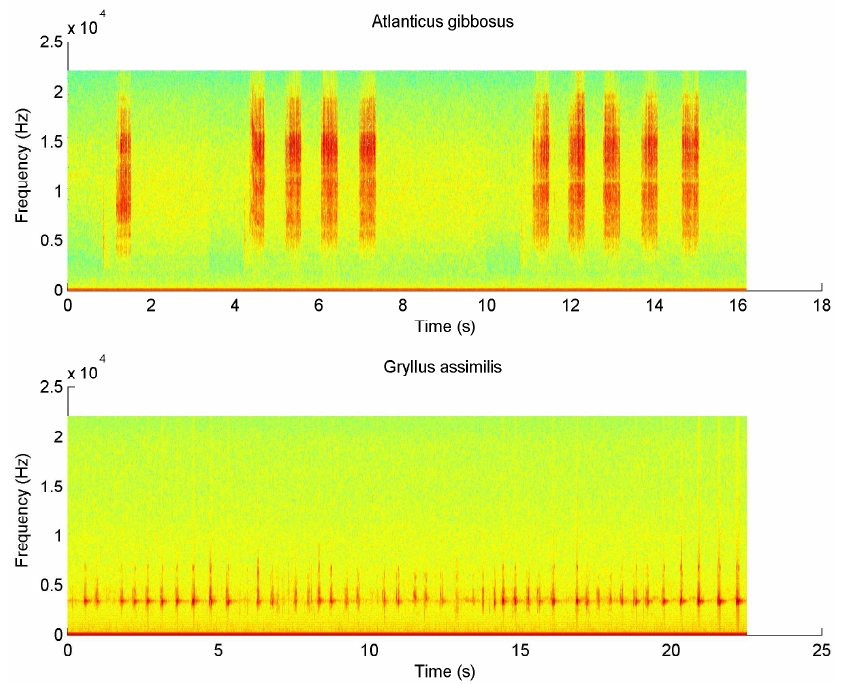
Figure 1. Example of two insect sound